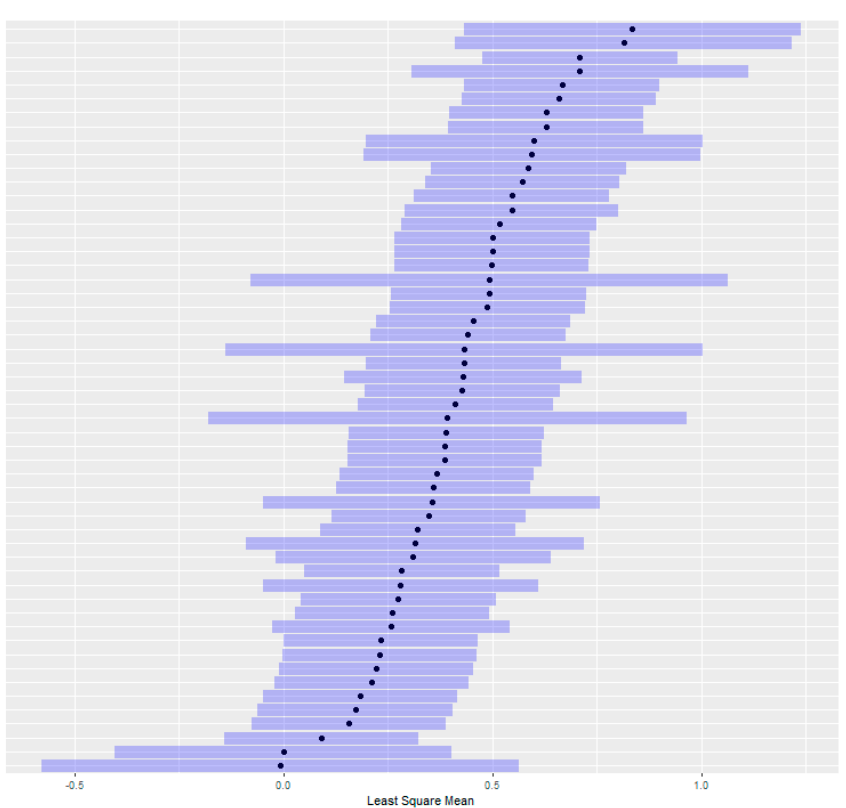
Figure A1. Least square means of full-sib CFGRP slash pine families screened using traditional USFS RSC protocols with confidence intervals. Note that the most tolerant (lower least square mean) families have overlapping confidence intervals with the least tolerant, indicating a lack of statistical differences.